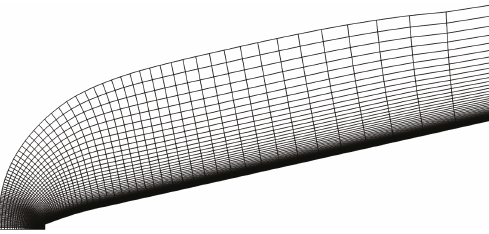
Figure 5: Gasjet model, mesh size